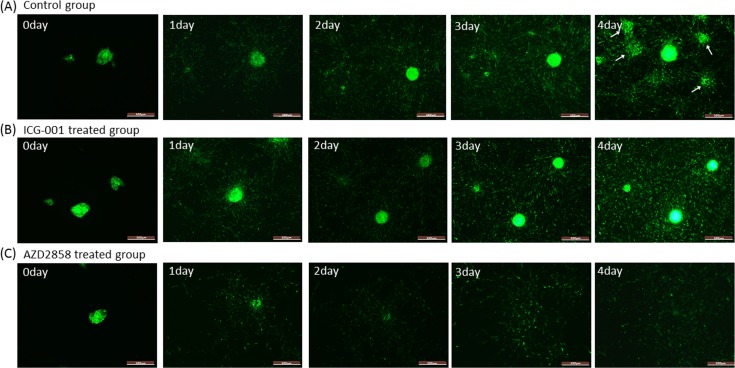
Time-course of EGFP-U87 glioma cell aggregates invasion into Matrigel.3D tumor spheroid invasion assay. U87 spheroid 3D invasion into Matrigel was monitored every 24 hours using fluorescence microscope. (A) Non-treated EGFP-U87 cells. (B) ICG-001 treated EGFP-U87 cells. (C) AZD2858 treated EGFP-U87 cells. The white arrows indicate newly formed colonies in control group. Bar: 500um.